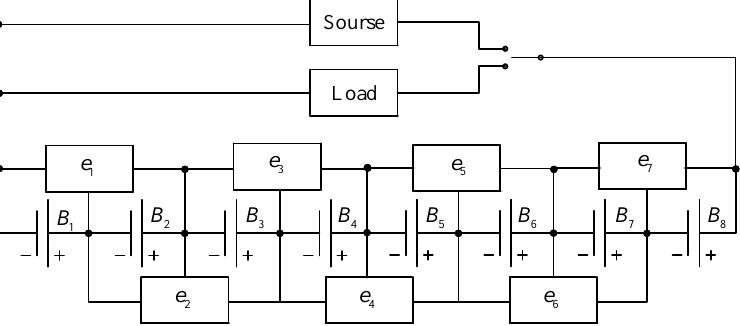
Figure 12. The adjacent cell balancing circuit.